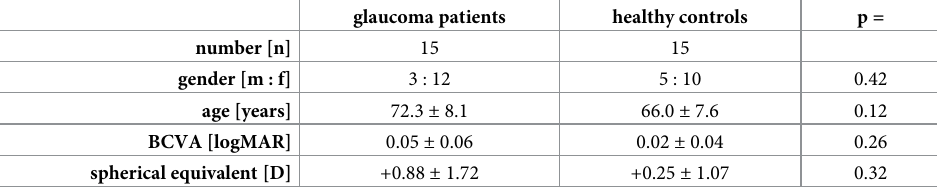
Table 1. Characteristics of glaucoma patients and healthy controls included in the analysis of SD-OCT results.